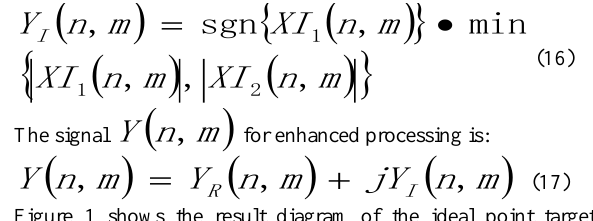
4.2 Airborne real data enhancement processing